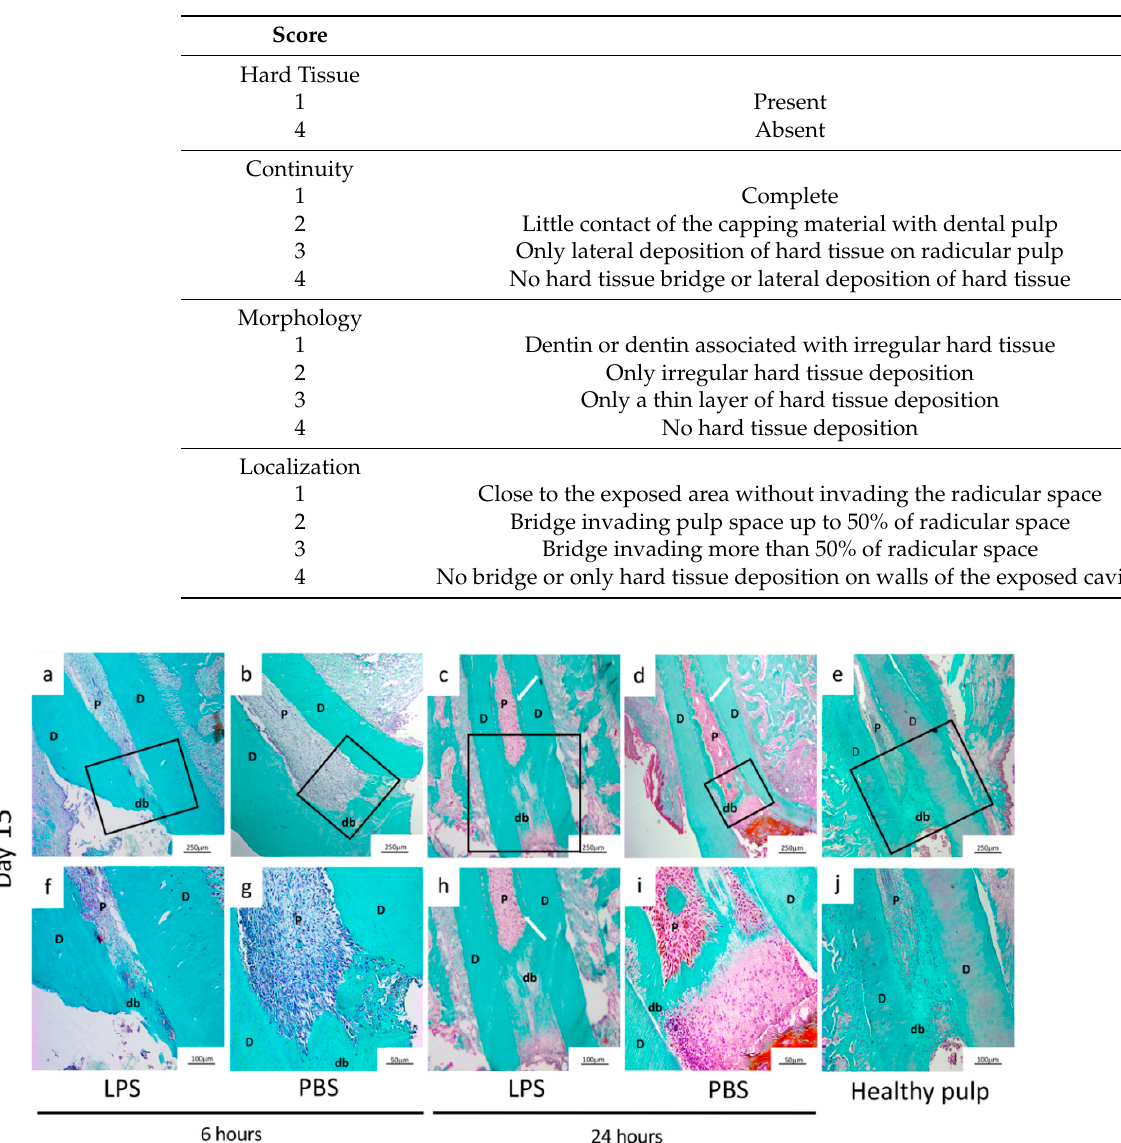
Table 3. Scoring table used for mineralization analysis on Masson’s trichrome histological sections on D15; representative sections presented in Figure 5a–j (LPS/PBS and 6/24 h conditions).